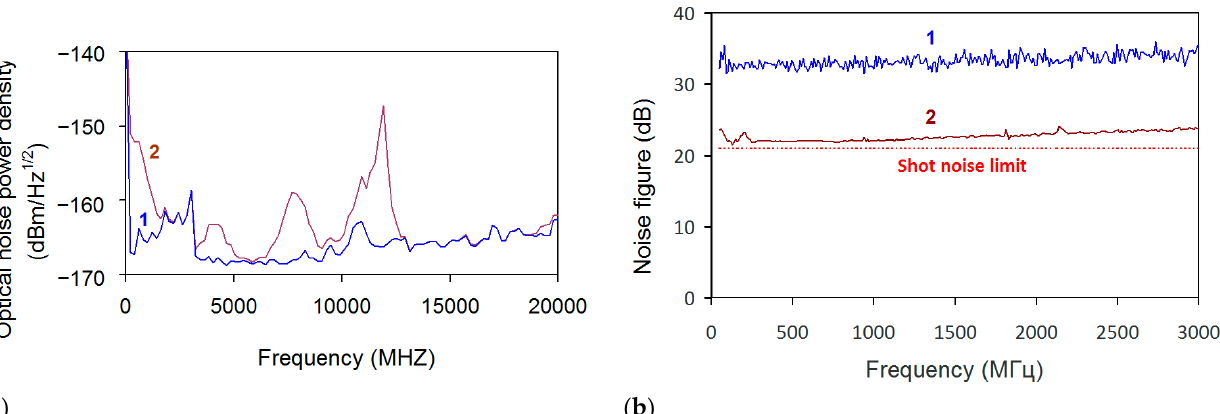
Figure 4. ( a ) The optical noise power density versus radio frequency: (1)—976 nm LD is switched off, (2)—976 nm LD is switched on. ( b ) Noise figure as a function of signal frequency (1) is the standard mode of amplitude modulation with direct detection; (2) is the balanced mode.